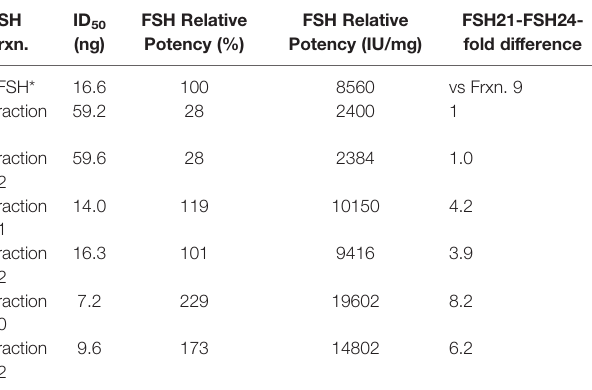
TABLE 2 | FSH receptor-binding activities of hFSH glycoform fractions. FSH